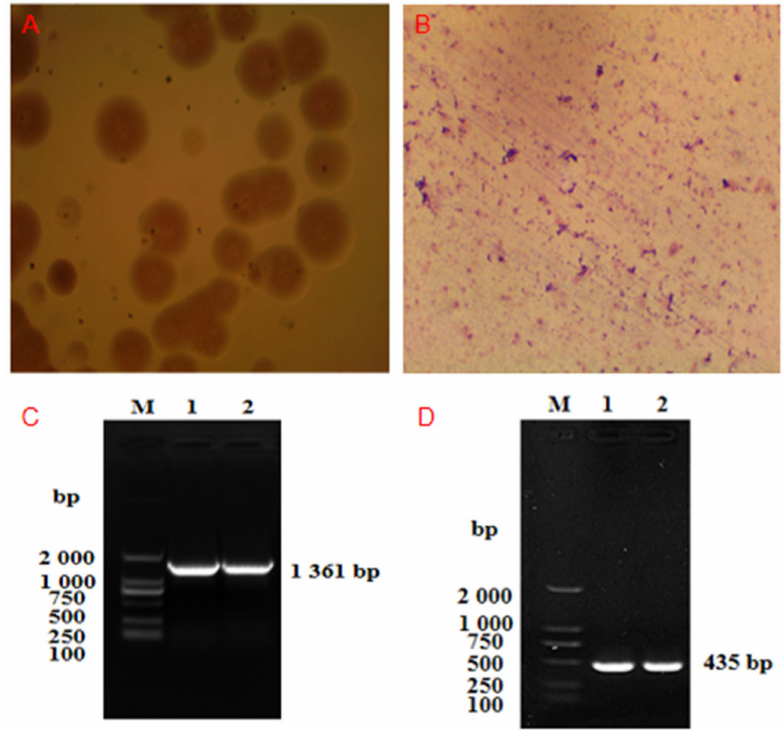
Figure 1. Isolation and identification of Mmc HN-A. ( A ), Colonies of isolated strains were observed under a microscope at low magnification (40 × ); ( B ), Giemsa staining results of isolated strains (1000 × ); ( C ), PCR identification of the 16S rRNA gene: (M) D2000 Marker, (Line 1) the isolated strain, (Line 2) the Mmc PG3 strain; ( D ), PCR identification of the Mmc 3740 gene: (M) D2000 Marker, (Line 1) the isolated strain, (Line 2) the PG3